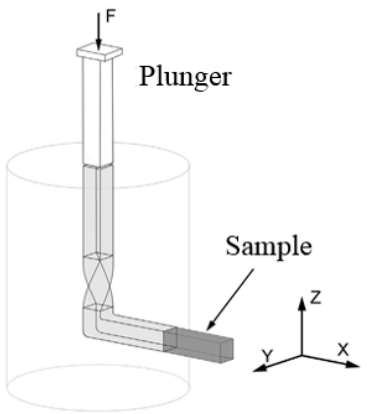
Figure 9. Schematic illustration of TCAP experiment design [81].